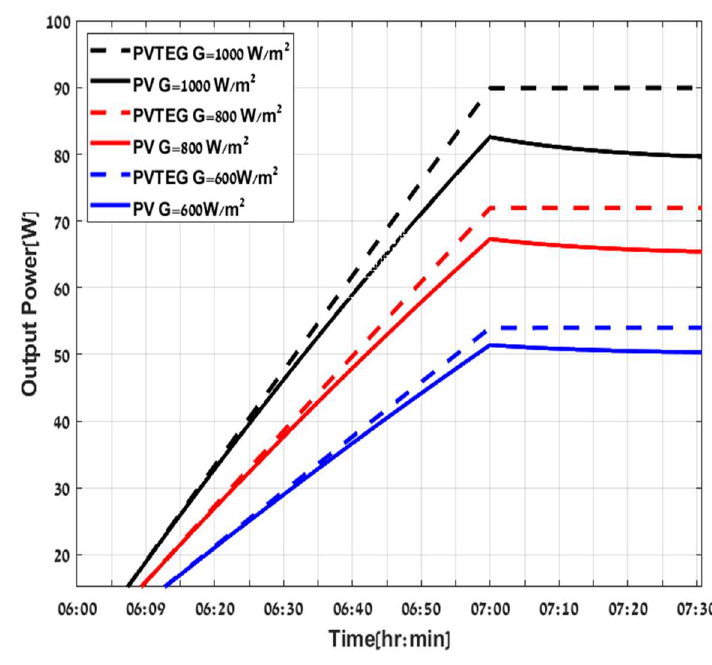
Figure 8. PV (continuous line) PVTEG (dashed line) at different G irradiance.